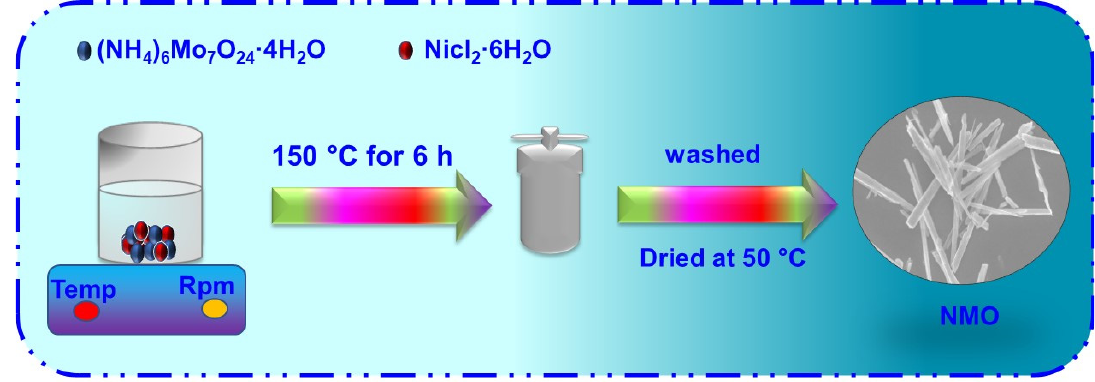
Scheme 1. Schematic Illustration of hydrothermal synthesis of NMO